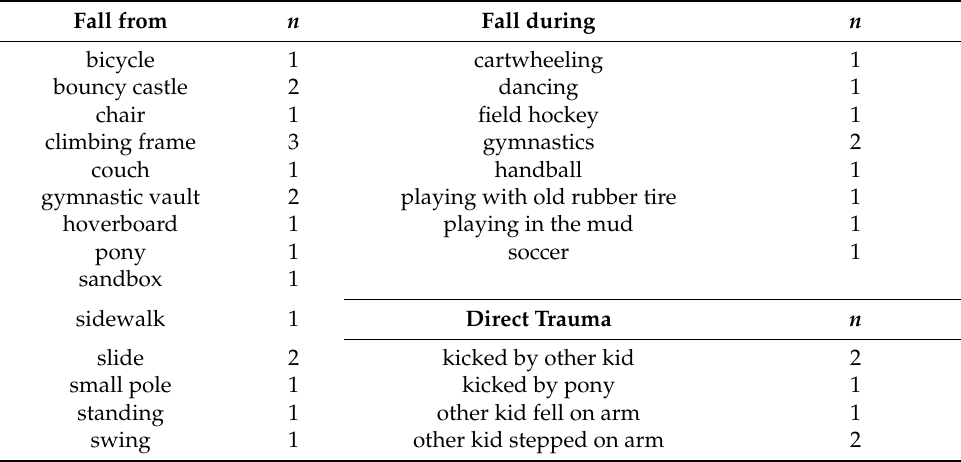
Table 2. Overview of reported trauma mechanisms ( n =